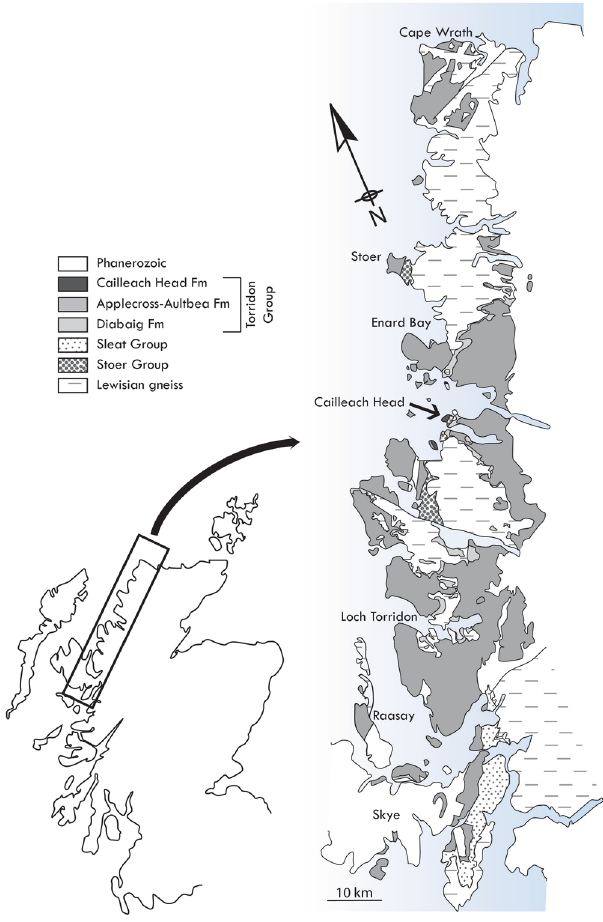
Figure 1. Map of NW Scotland showing generalized bedrock geology, and location of the material sampled for this study from the Cailleach Head Peninsula (small